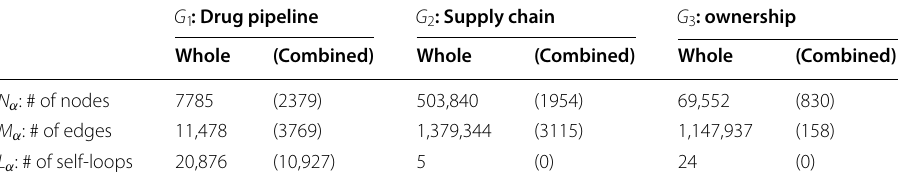
Table 3 The number of nodes, edges, and self-loops before combining Coritellis and Capital IQ